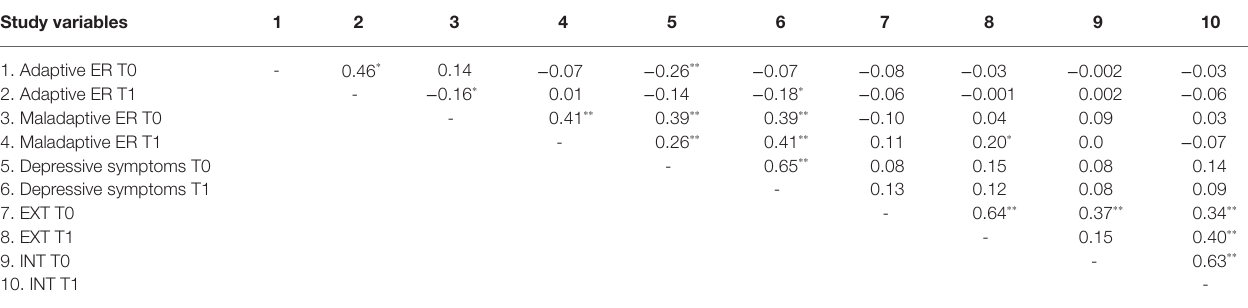
TABLE 5 | Correlations (Pearson’s r ). Study